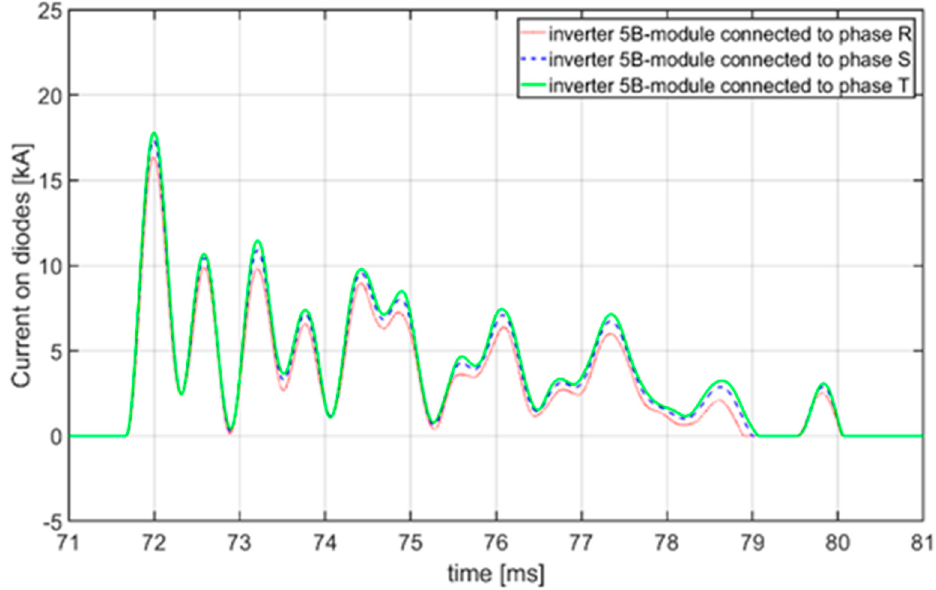
Figure 9. Test setup condition with all inverter modules connected: current in diodes of the healthy modules presenting the highest inverse current peaks during an internal fault in AGPS operation with all inverter modules connected.